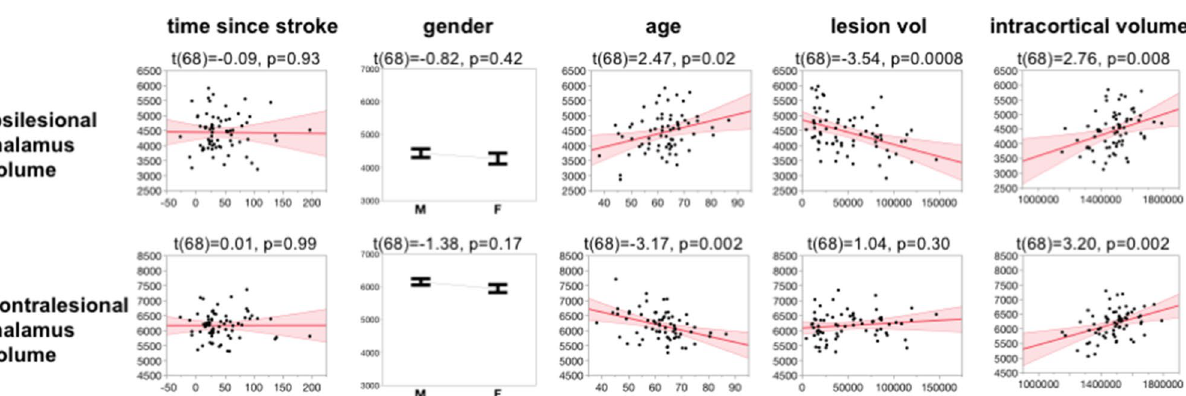
Figure 3. Modeling results of ipsilesional and contralesional thalamus volume. T-statistic and probability are shown above each